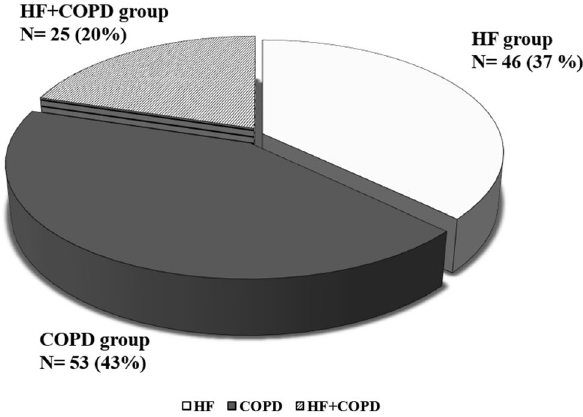
Figure 2. Prevalence of patients with HF + COPD overlap in studied populations. HF heart failure, COPD chronic obstructive pulmonary